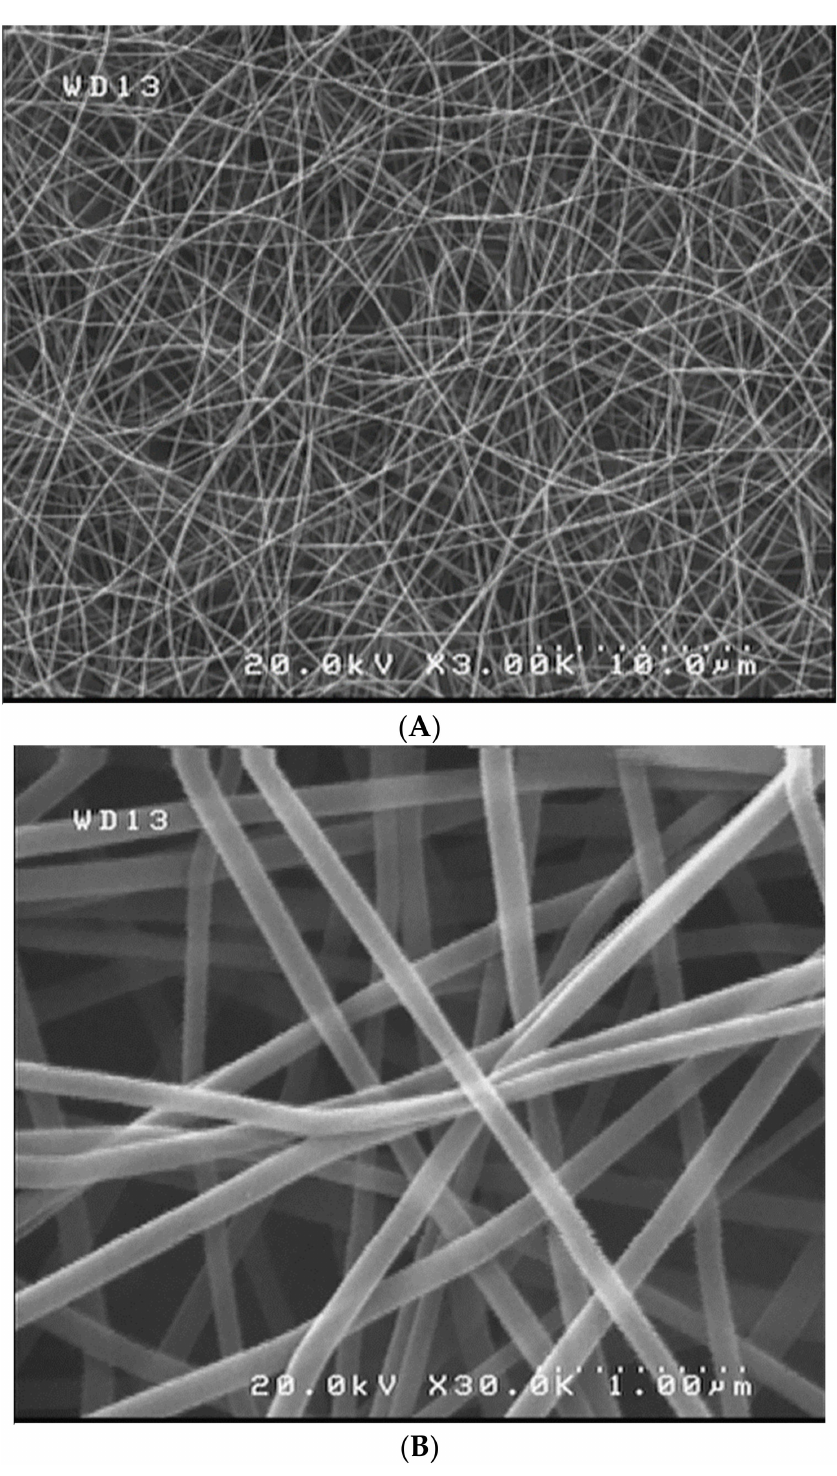
Figure 8. FESEM micrographs of the confirmation experiment with magnifications of 3000 ( A ) and 30,000 ( B ) for the optimum combination of